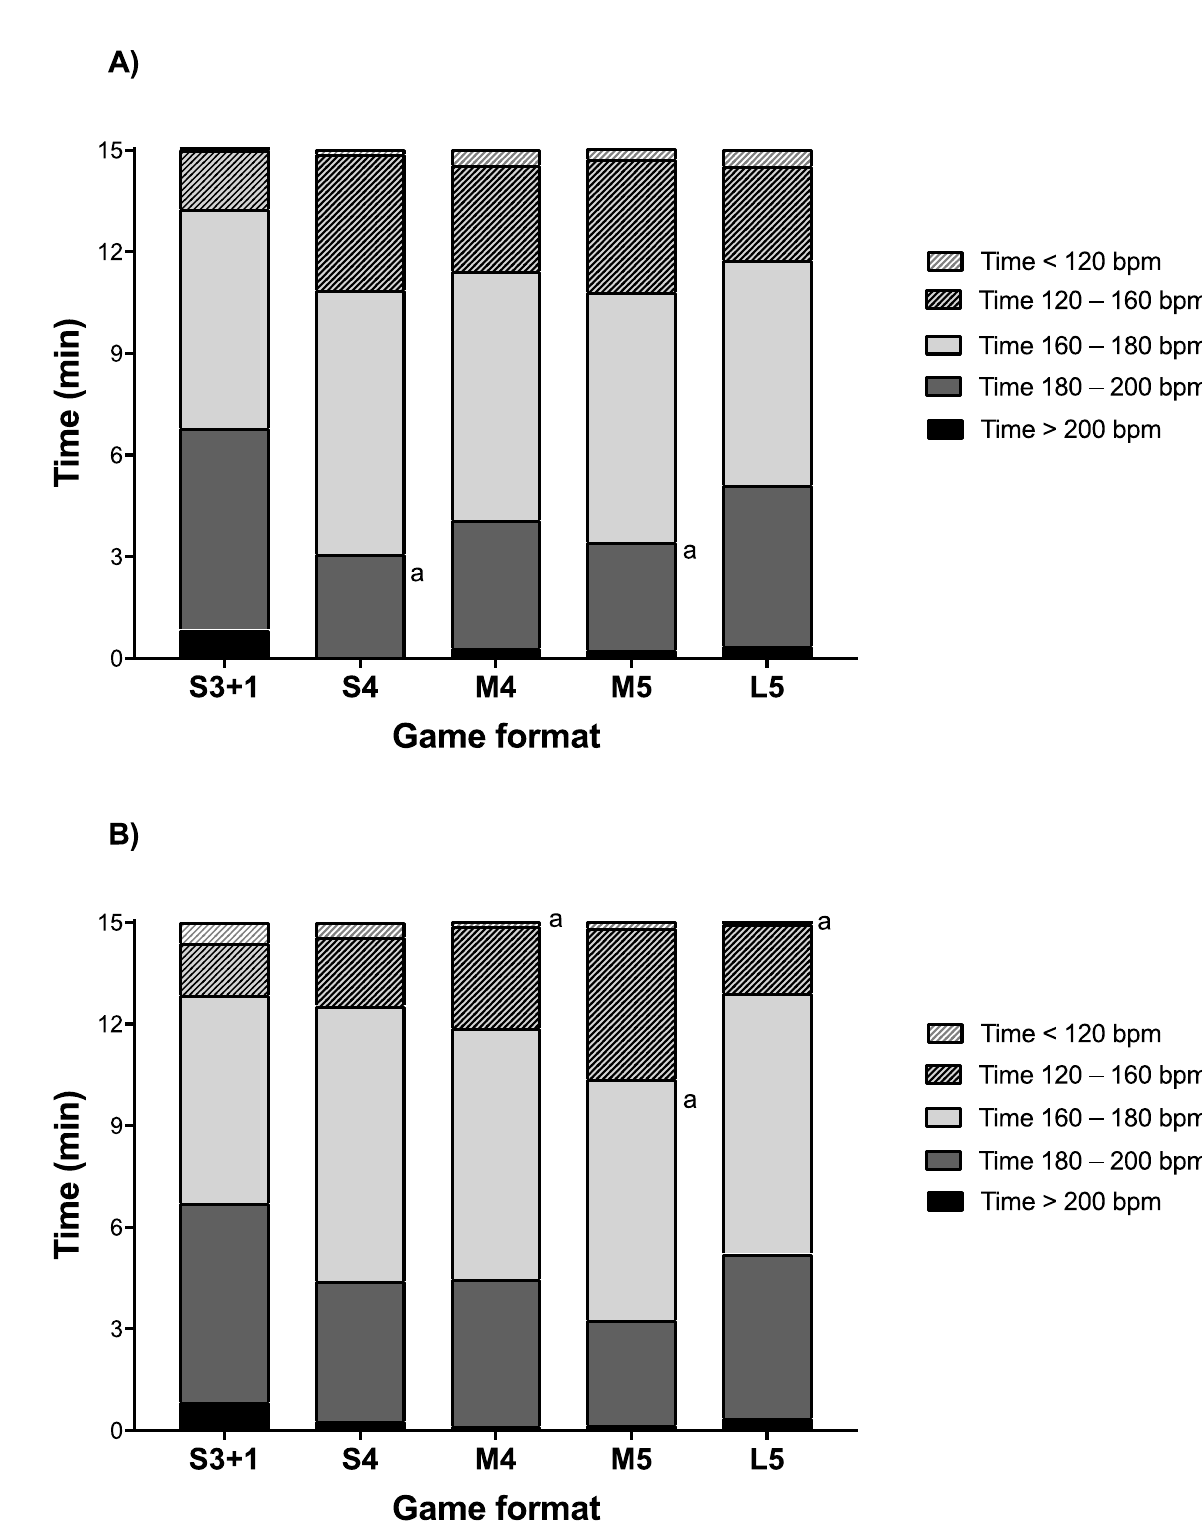
Figure 4. Heart rate distribution during U9 ( A ) boy and ( B ) girl handball games. S3 + 1: small size, 3 v 3 + offensive goalkeeper; S4: small size, 4 v 4; M4: medium size, 4 v 4; M5: medium size, 5 v 5; L5: large size 5 v 5. a denotes significant differences compared to S3 + 1 ( p ≤ 0.05).